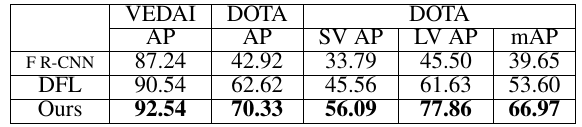
Table 2. Experimental results (AP) on the training set of DLR 3K with the models trained on different other datasets. These experiments evaluate the generalization ability. For comparison, we cite the results of HRPN trained and evaluated on DLR 3K. Features from